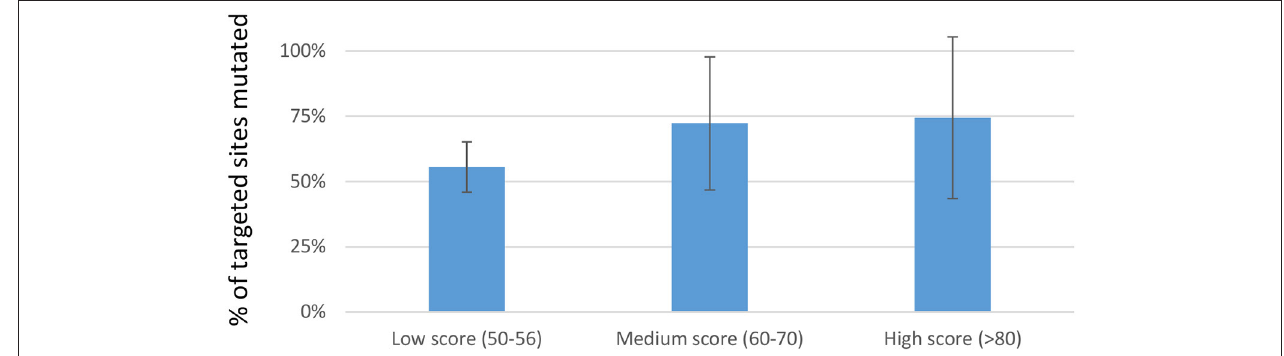
FIGURE 1 | Percentage of targets mutagenized when multiplexed sgRNAs where separated into sets based on CRISPRscan score. For each set, three pools of 6 sgRNAs were prepared. Each pool of 6 sgRNAs was co-injected with Cas9-encoding mRNA into 1-cell embryos. Data is represented as the mean ± sd of targets mutated in each set. Although a trend toward improved mutagenic efficiency is evident, no statistically reproducible differences were